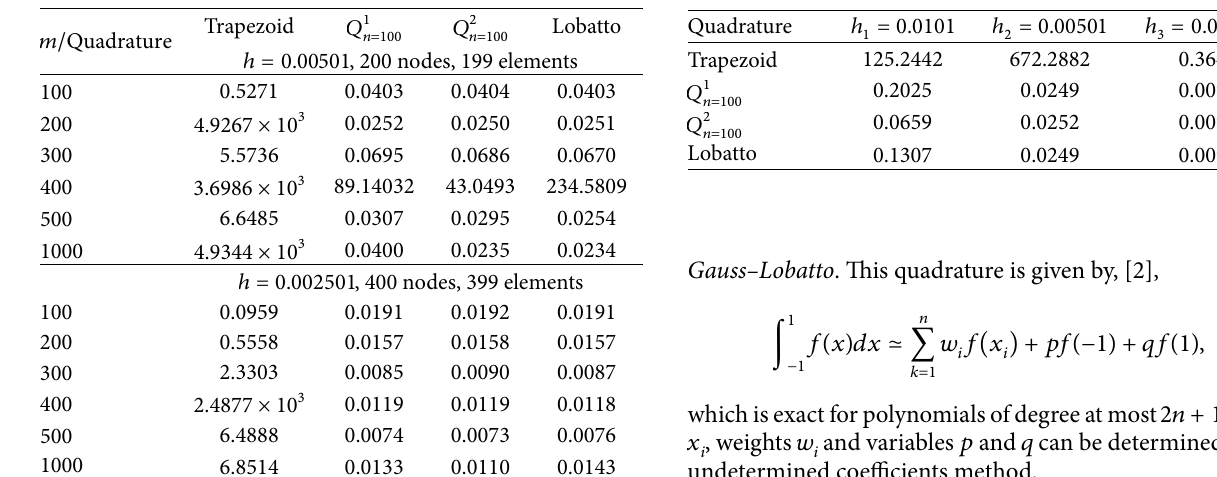
Figure 3: Diffusion parameter Table 2: Relative error for different values of